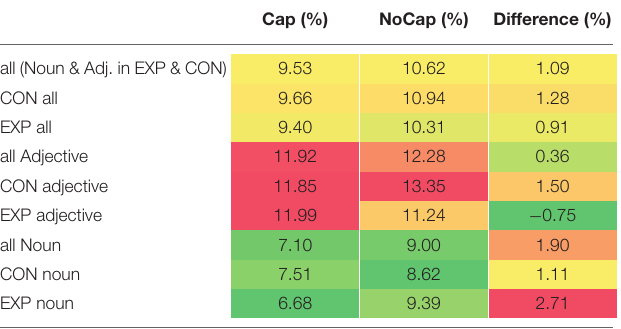
TABLE 5 | Gaze duration depending on the Frequency of the Noun, model data for the independent variables of the Fixation Duration.